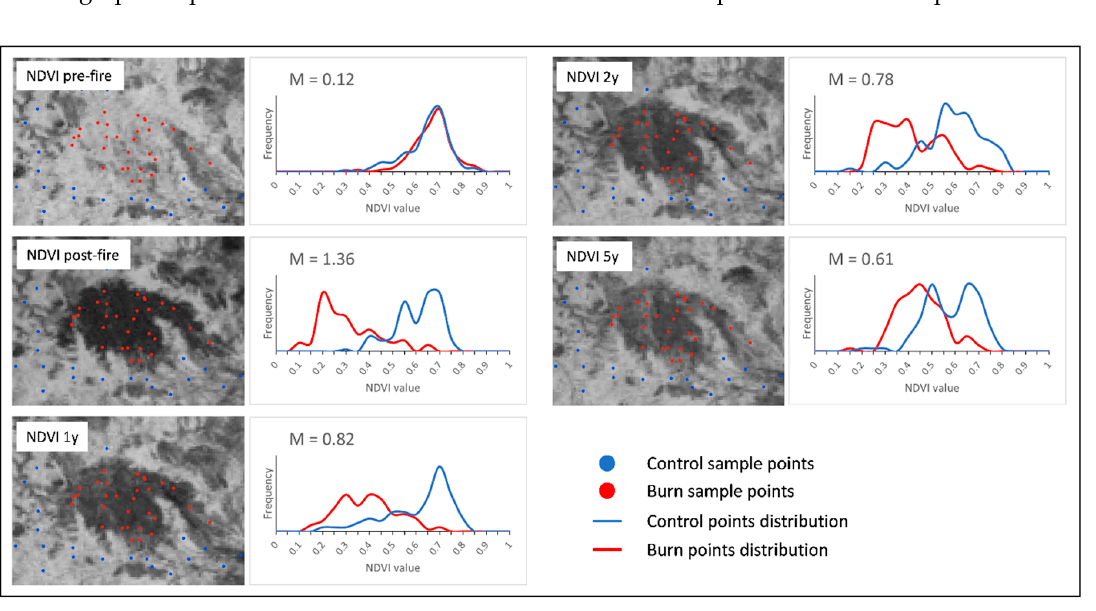
Figure 3. Burned vs. unburned class distributions for the NDVI at pre-fire, post-fire, and 1, 2, 5 years after fire. An example of burn scar, burn and control sample points, as well as the M -statistic results are illustrated.